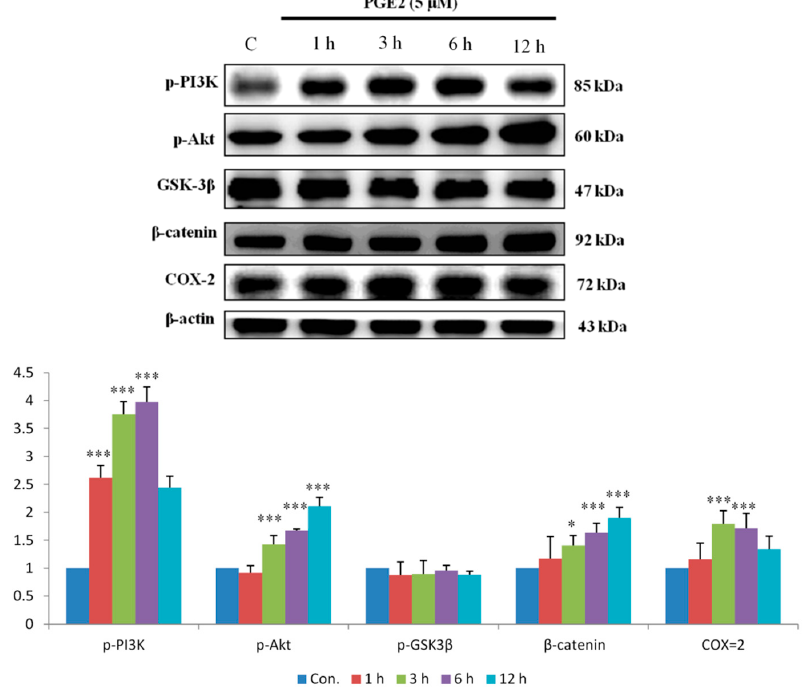
Figure 2. PGE2 promotes the expression of Phosphatidylinositol-4,5-bisphosphate 3-kinase PI3K, Akt, p-GSK3 β , β -catenin and COX-2 proteins in LoVo cells. LoVo cells were treated with 5 μ M PGE2 for 1, 3, 6 and 12 h. Cells were harvested and lysed at the indicated time points. Cell extracts were separated by 12% SDS-PAGE, transferred to PVDF membranes, and immunoblotted with antibodies against PI3K, Akt, p-GSK3 β , β -catenin and COX2. The expression of these downstream proteins exhibited an increasing trend with longer PGE2 treatment times. * p < 0.05, *** p < 0.001 denotes significant differences from control values. The results were presented as the mean ± SD of three difference experiments.